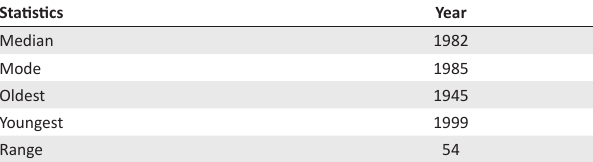
TABLE 2: Descriptive statistics of the years of birth of